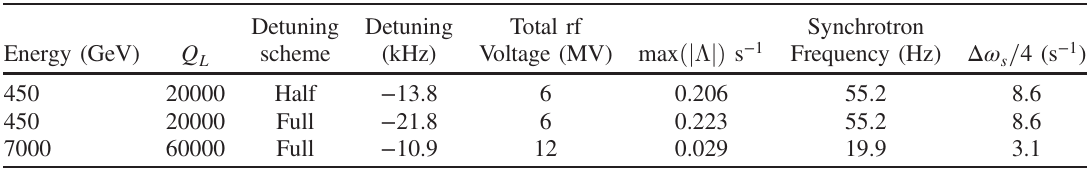
TABLE VIII. Maximum value of j Λ n j over all n caused by the impedance of the eight cavities at the fundamental. OTFB